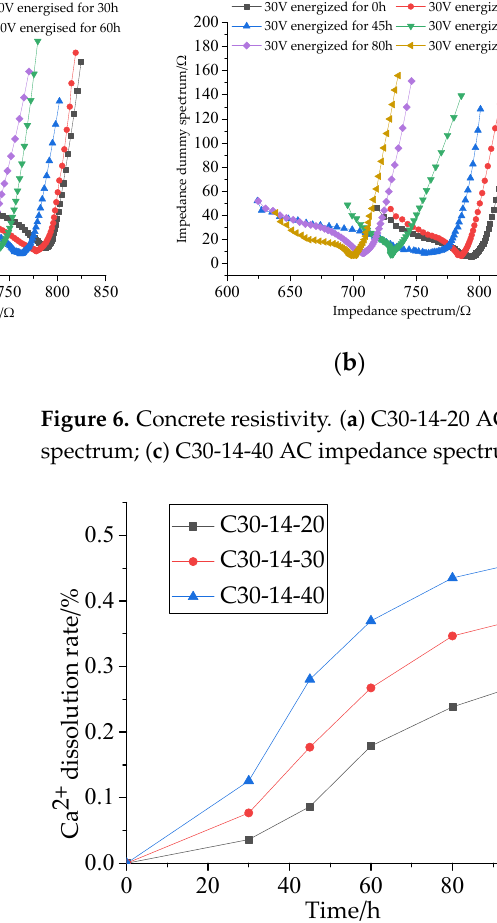
Figure 7. Change of calcium ion dissolution rate.